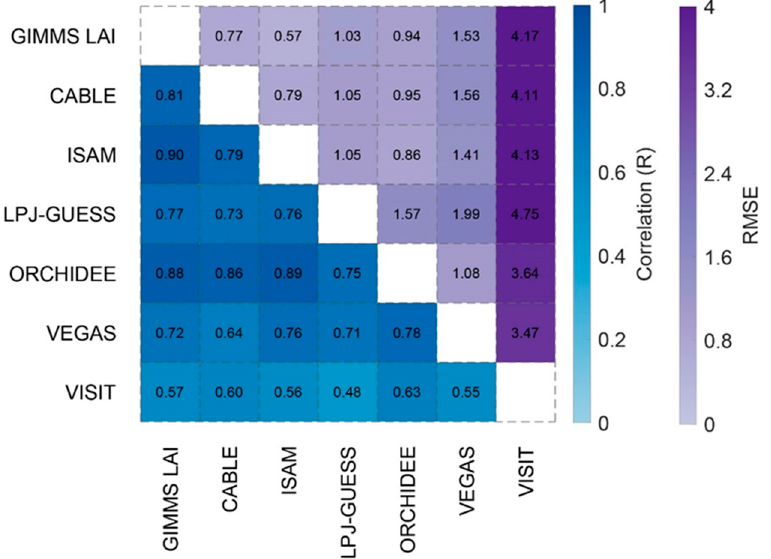
Figure 1. Pearson correlation and root-mean-square error (RMSE) between annually averaged GIMMS LAI and modeled LAI from 1982 to 2015 at the grid scale.